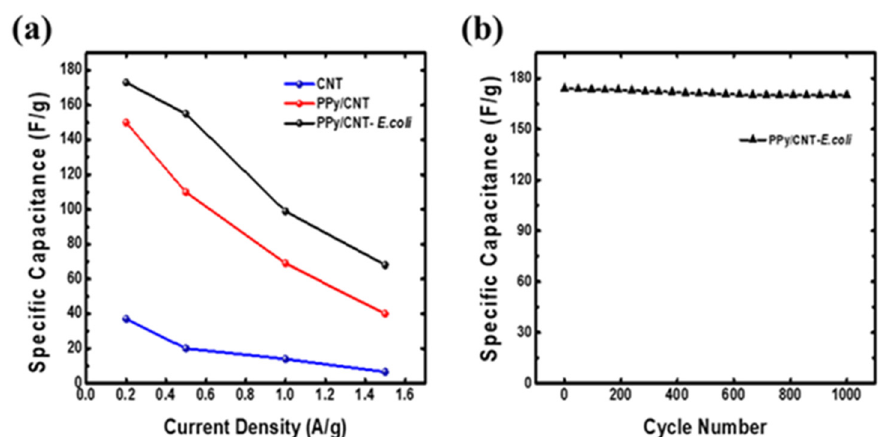
Figure 6. ( a ) Specific capacitances of CNT, PPy/CNT and PPy/CNT– E. coli vs. current density and ( b ) PPy/CNT– E. coli ’s specific capacitance as a function of cycle number.